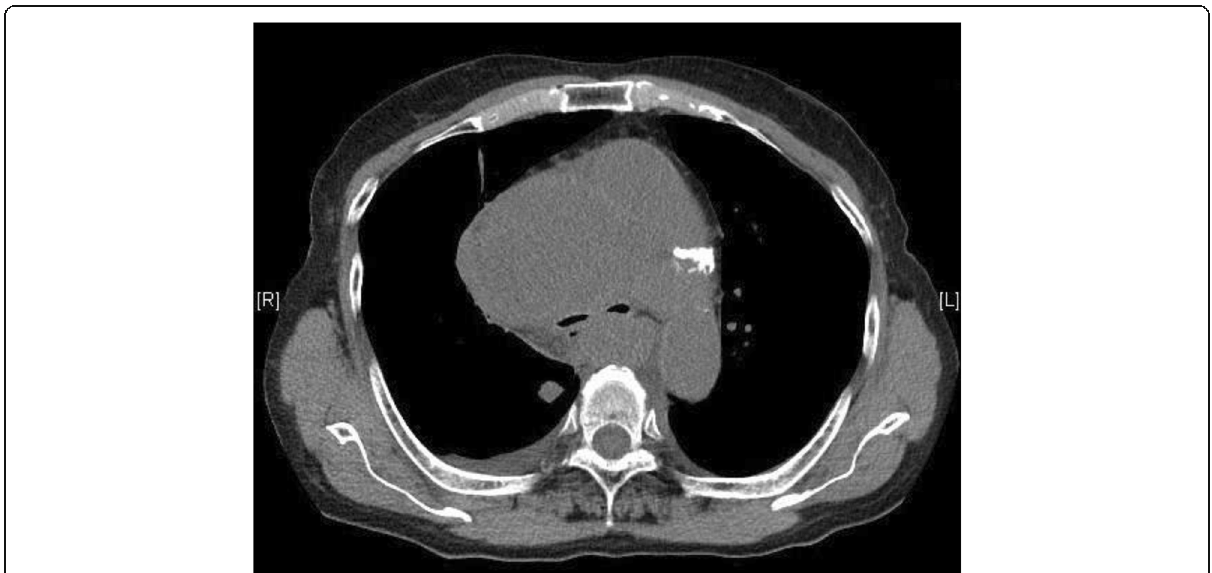
Fig. 2 Preoperative chest computed tomography at the level of the main bronchus. Bilateral main bronchi were remarkably compressed by the anterior mediastinal